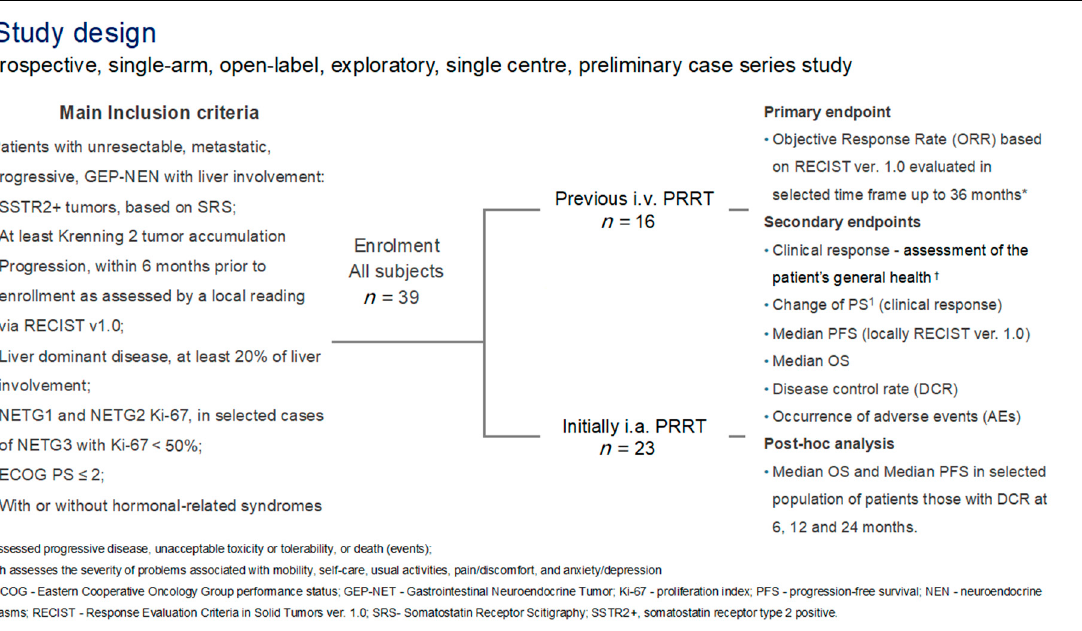
Figure 1. Study design, including main inclusion criteria, selection of two groups of patients, and endpoints.